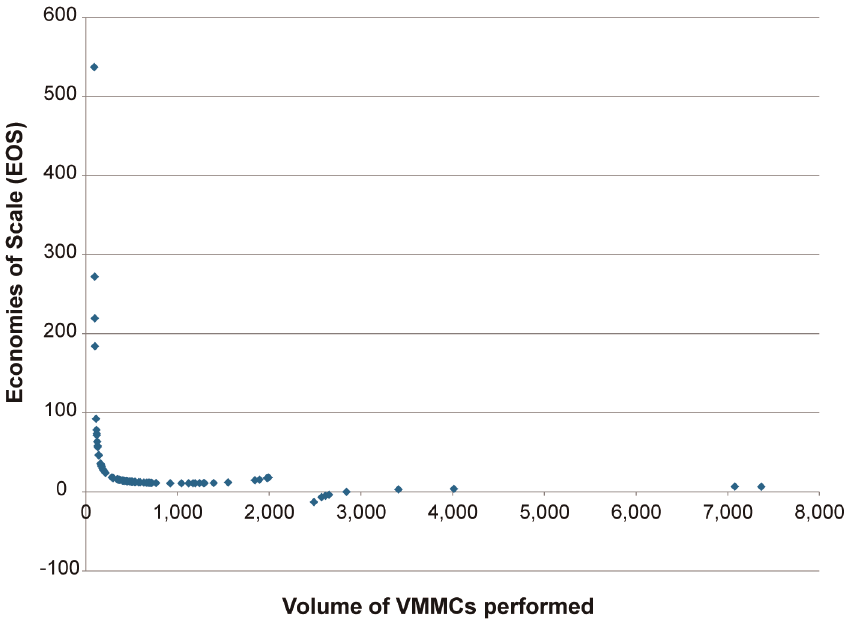
Figure 2. Predicted economies of scale of VMMC programs. Blue diamond: predicted economies of scale.